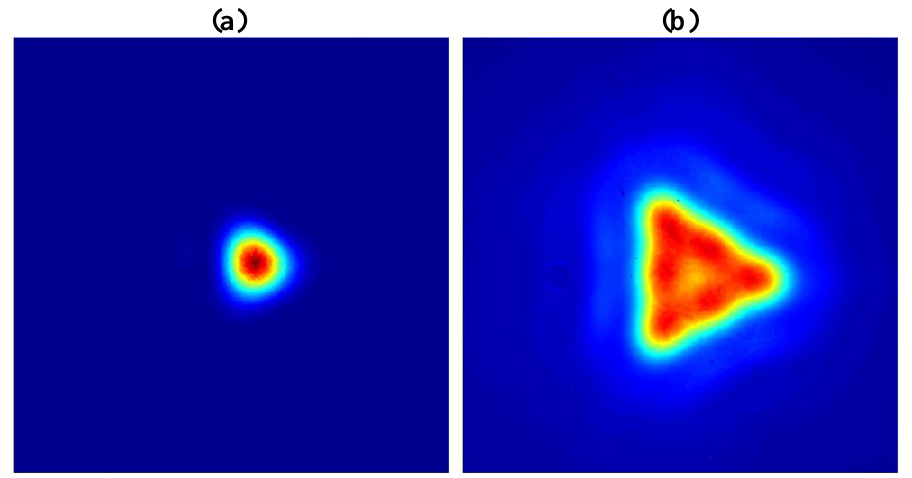
Figure 6. (a) Mode image of 532 nm excitation. Fiber filled with decane to ensure correct mode profile for comparison to fluorescence mode image. (b) Mode image of very high concentration (1 µM) Qdot 800 fluorescence mode excited with 532 nm source. Scales are directly comparable between (a) and